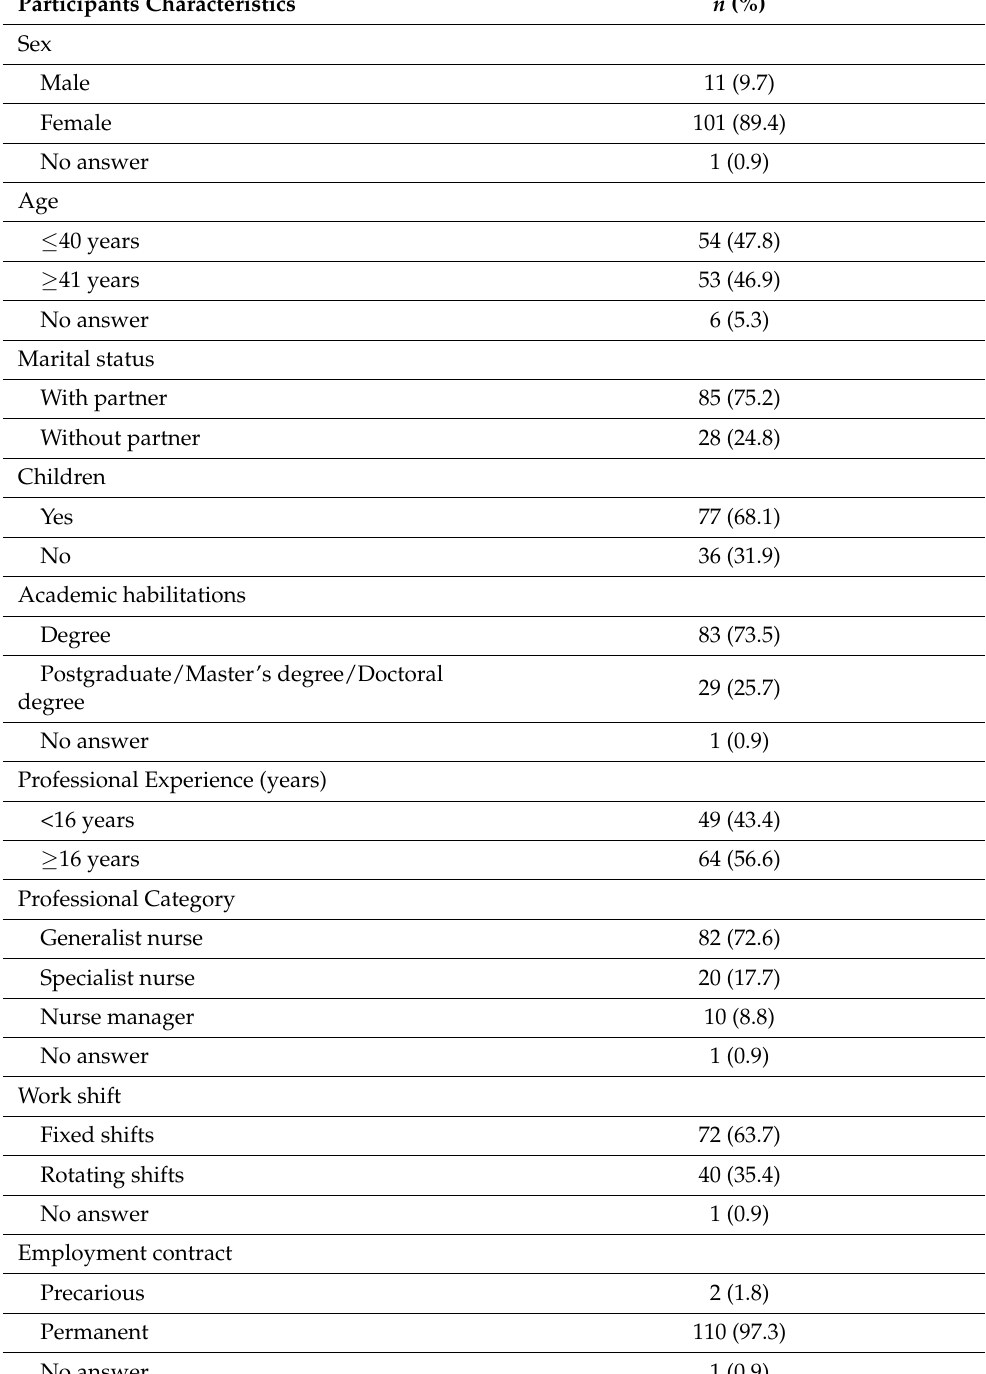
Table 1. Participants